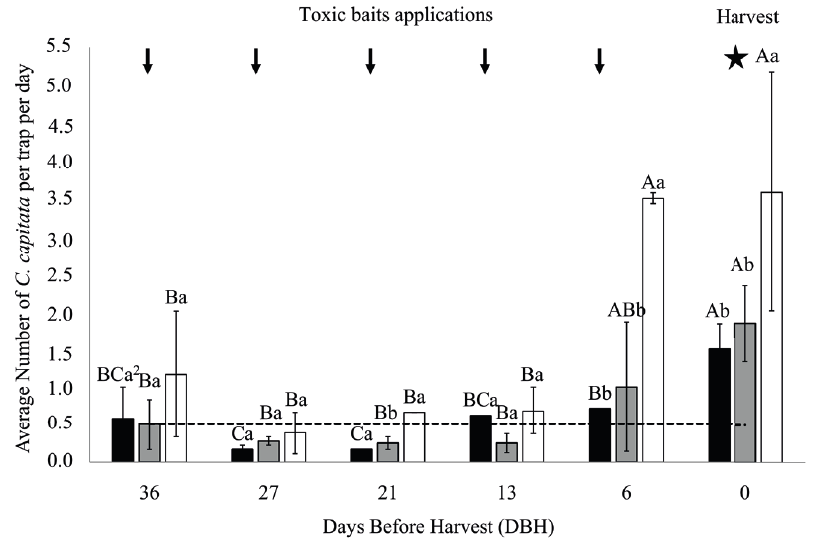
Figure 1 - Number of Ceratitis capitata captured in four Jackson traps on ‹Sugar Crisp› grapevines during the six-week evaluation period in plots with Gelsura™ toxic baits (1:2 parts of water) and Success™ 0.02 CB (1:1.5 parts of water). Area 1: Casa Nova, BA, February to March, 2017. 2 Number of fl ies per trap per day (FTD) followed by equal capital letters over the course of six weeks of evaluation and by the same lowercase letters within the evaluation week do not diff er (Tukey’s test at 5% probability of error). Dashed line indicates the level of control (0.5 FTD). *Control plot without the application of